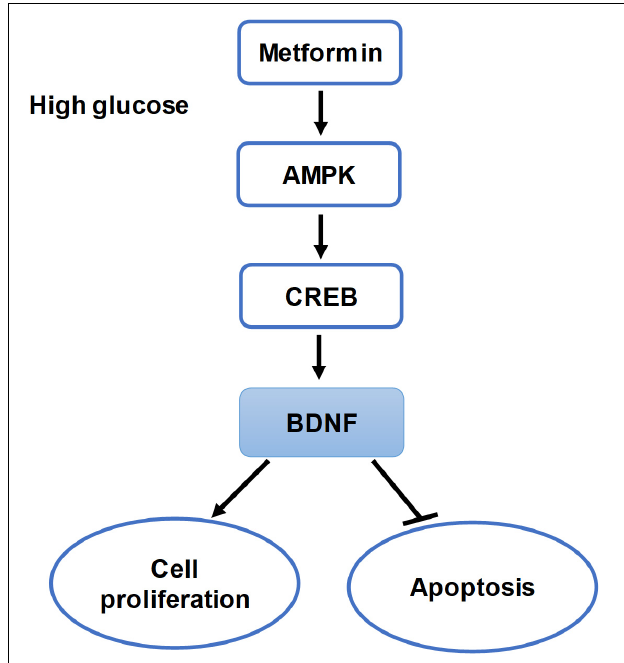
FIGURE 8 | Summary of the hypothesis of the study. Schematic of this study that metformin improves cell proliferation and ameliorates cell apoptosis via the AMPK/CREB/BDNF pathway in HG-incubated